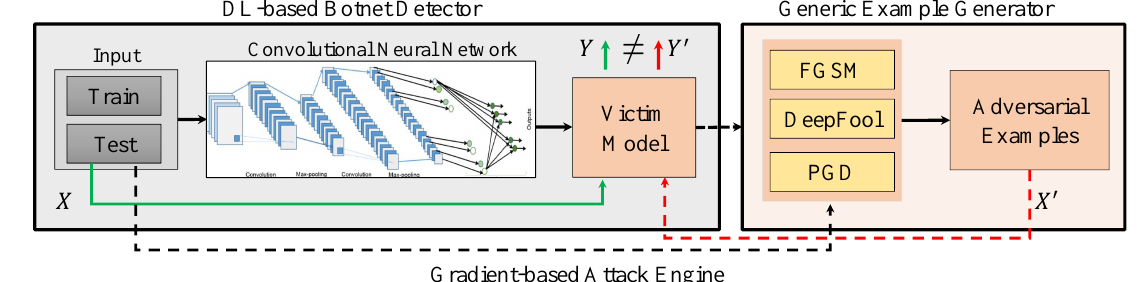
Figure 2. General structure of the generic adversarial attack on deep learning-based botnet detection systems. In this work, we utilized three common gradient-based adversarial attacks on our DL-based botnet detector (victim model), including Fast Gradient Sign Method (FGSM), DeeFool, and